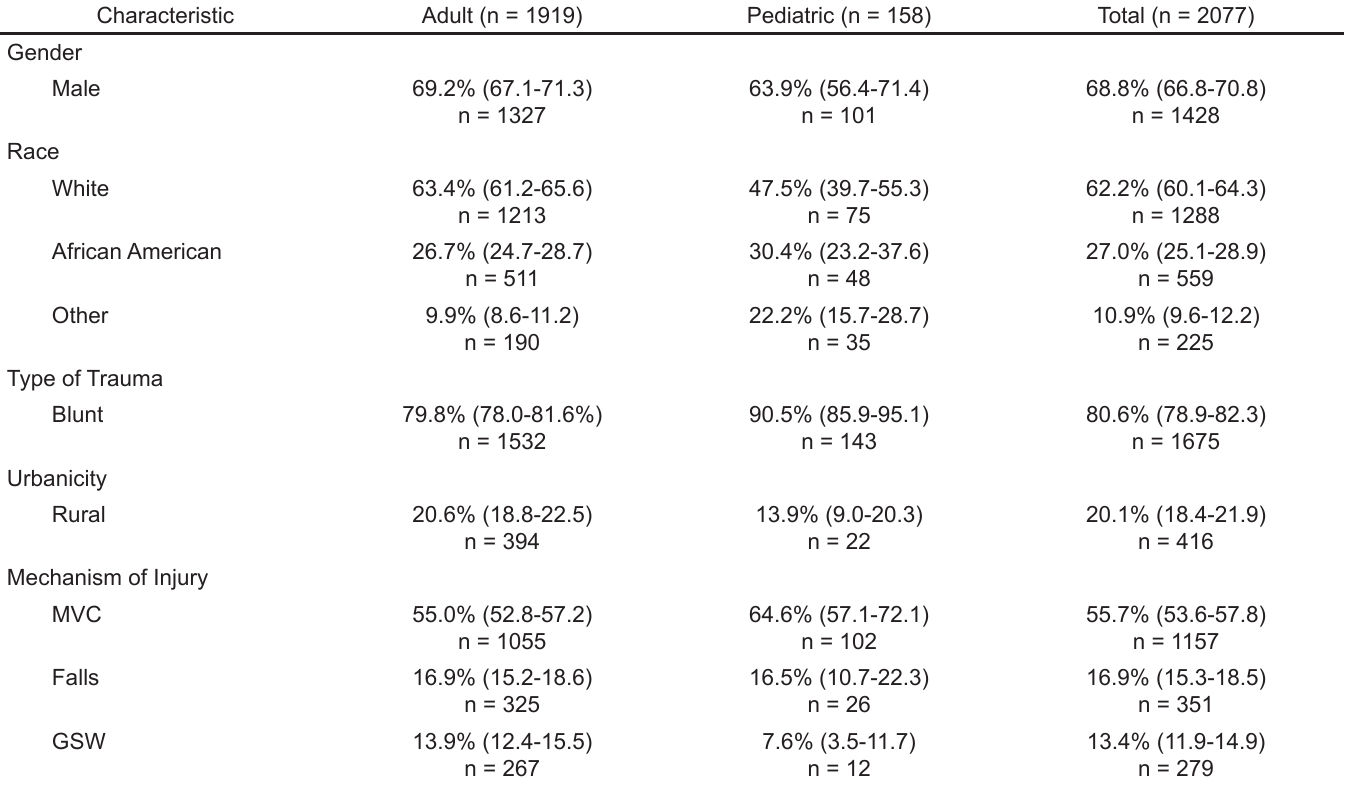
Table 1. Descriptive statistics for the study population by age group with 95% confidence interval reported.